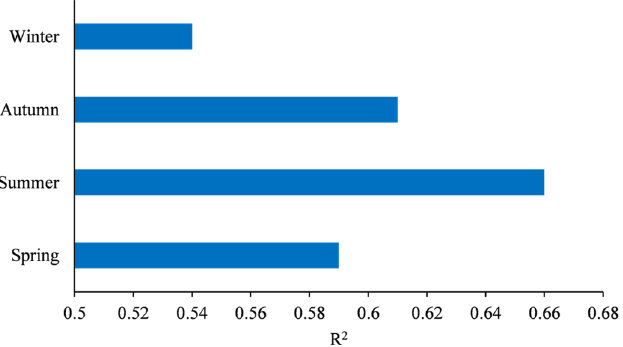
Figure 8. R 2 -based accuracy evaluation of the hybrid model for different seasons.